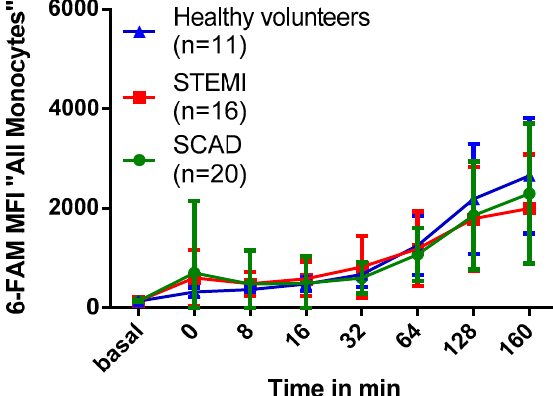
Figure 7. Impact of myocardial infarction on PFOB-NE phagocytosis. Whole blood samples of patients with STEMI, SCAD or healthy volunteers were exposed to PFOB-NE for di ff erent periods of time. MFI in the 6-FAM-channel as a parameter for the amount of ingested particles was evaluated by flow cytometry. No significant di ff erences in PFOB-NE uptake of human monocytes could be observed between patients with STEMI, SCAD and healthy volunteers.